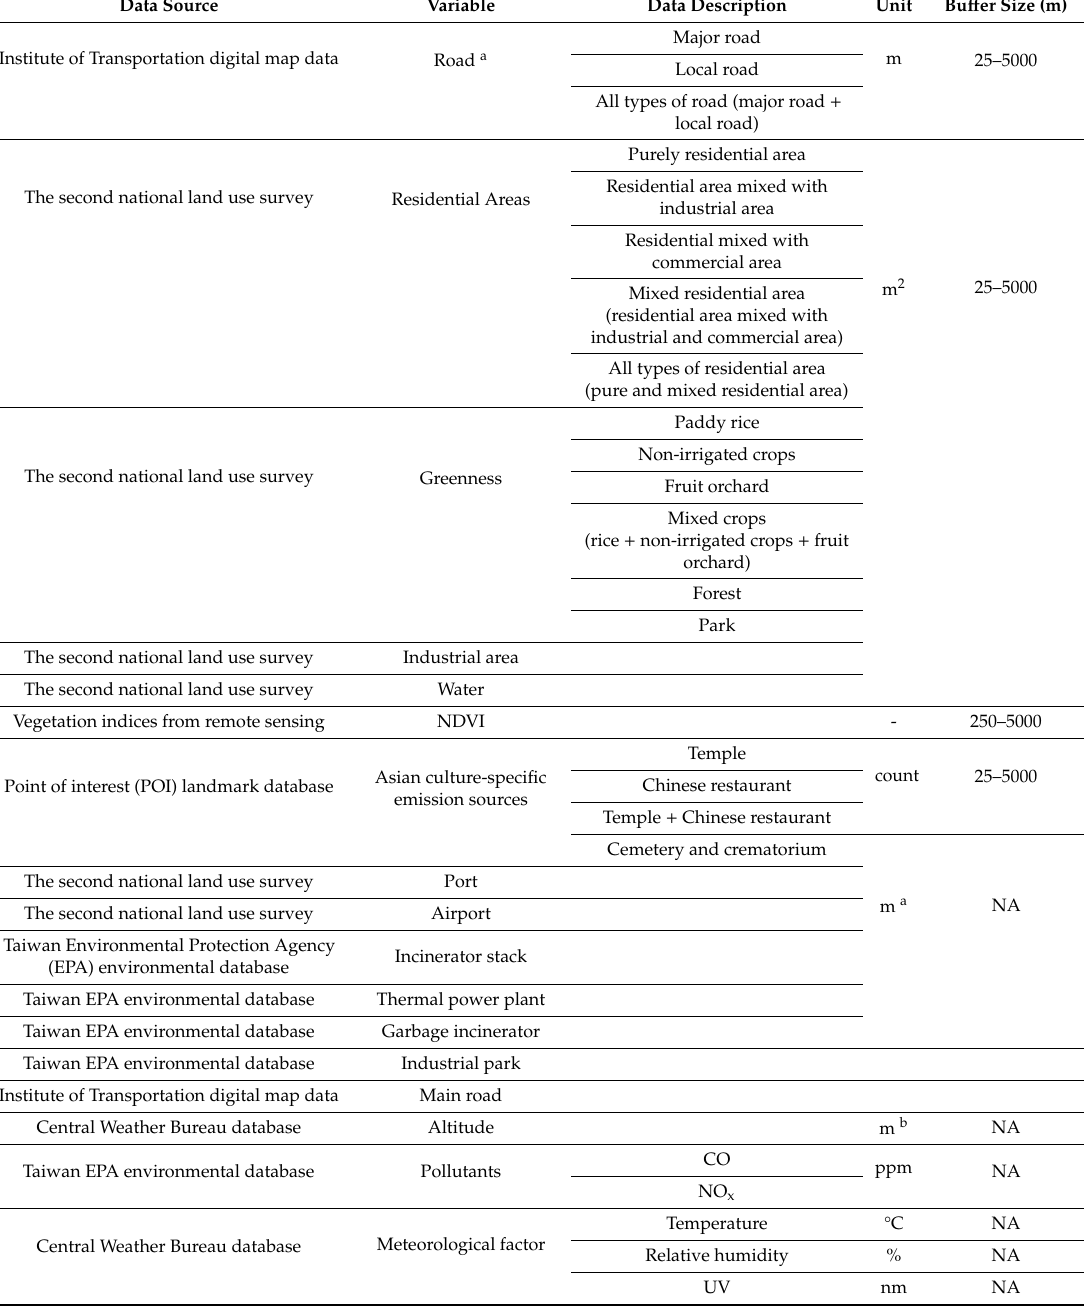
Table 1. Potential predictor